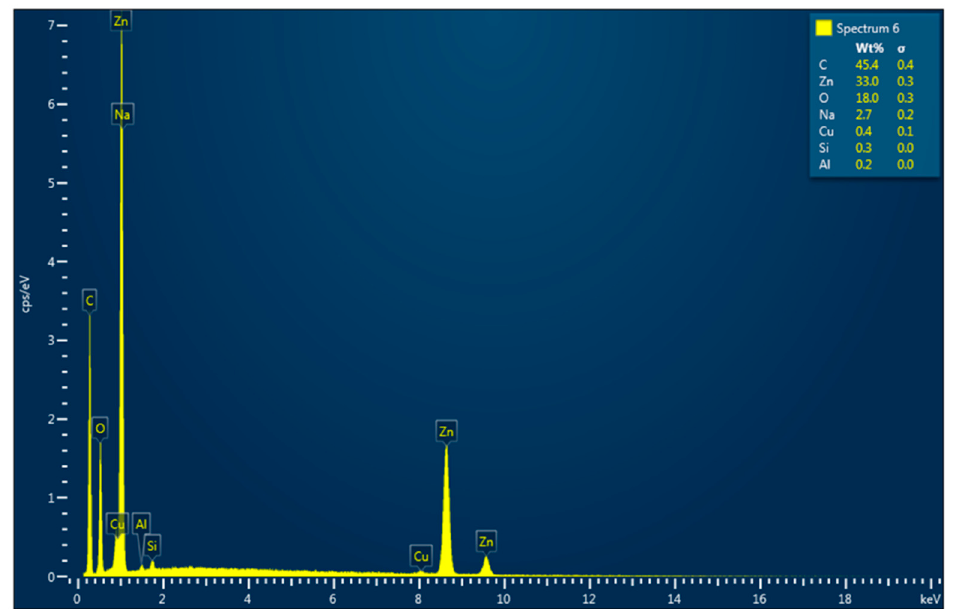
Figure 3. SEM image of AmB-PEG-ZnO sample.